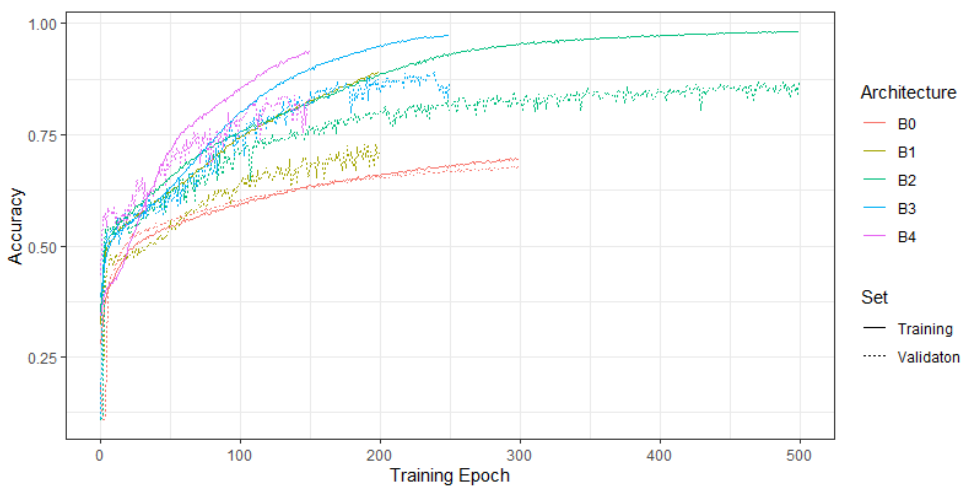
Figure 3. Training and validation accuracy of the model with the highest validation accuracy as per EfficientNet.